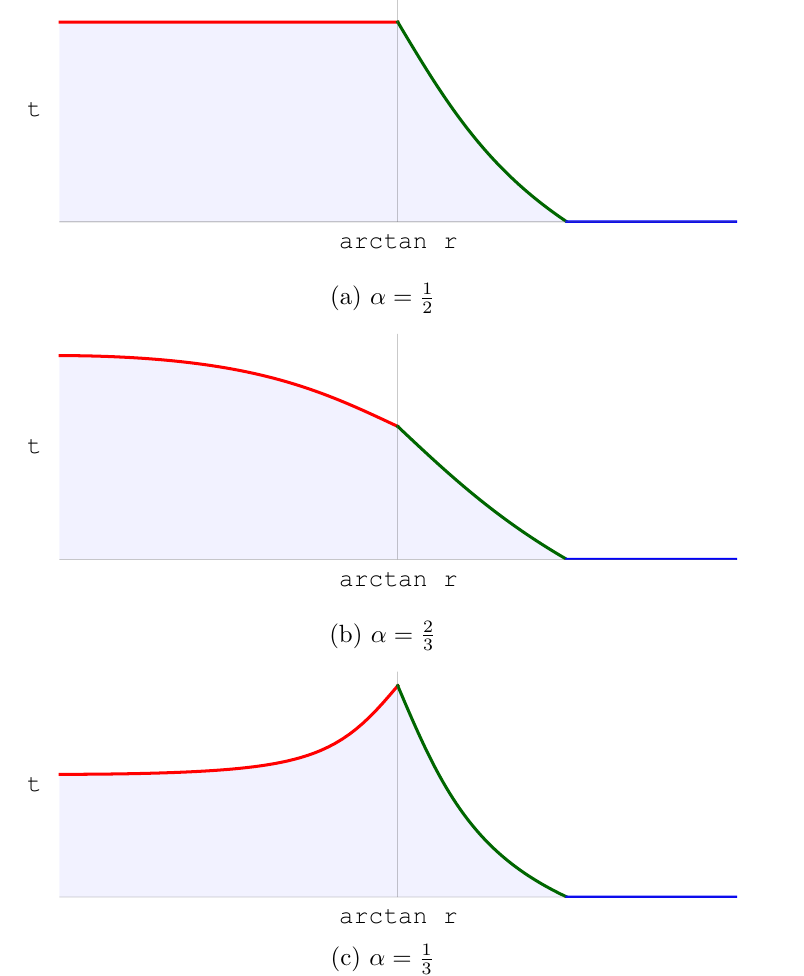
Figure 4. A side view of the entanglement wedge for regions covering more than half of the boundary in the conical de(cid:12)cit for various values of (cid:11) . The HRT surface is depicted in blue, the ingoing light ray in green, the caustic in red and the interior of the entanglement wedge is shaded in light